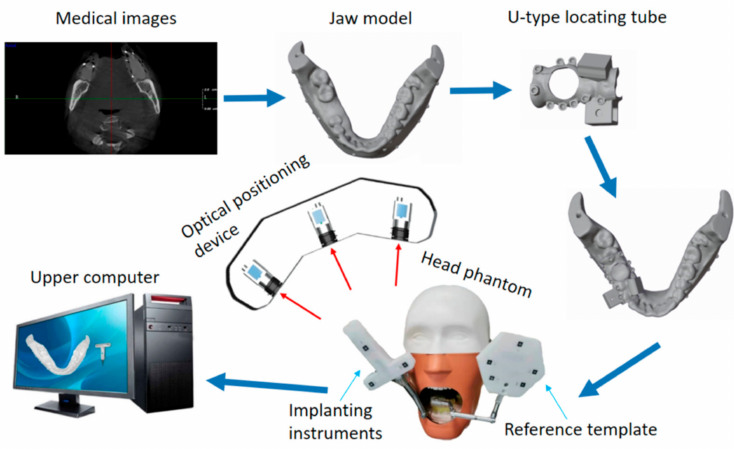
Figure 1. The scheme of the dental implant navigation system (DINS) is based on trinocular stereo vision